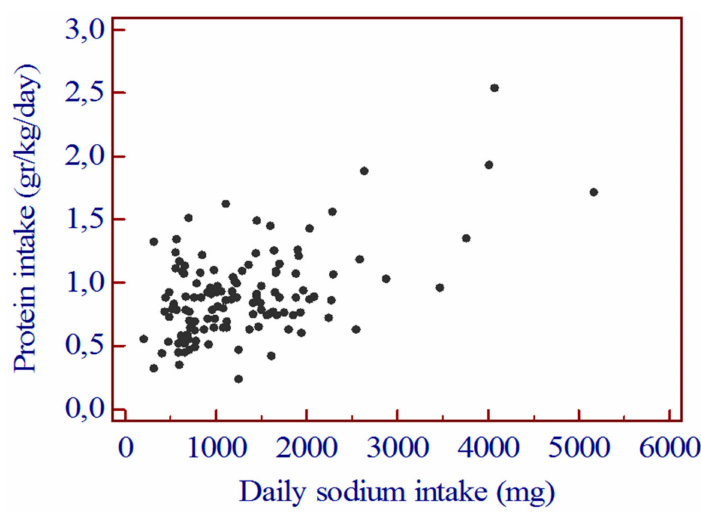
Figure 2. Correlation between daily sodium intake and daily protein calorie intake. r = 0.530 [0.392–0.644]; p < 0.0001.